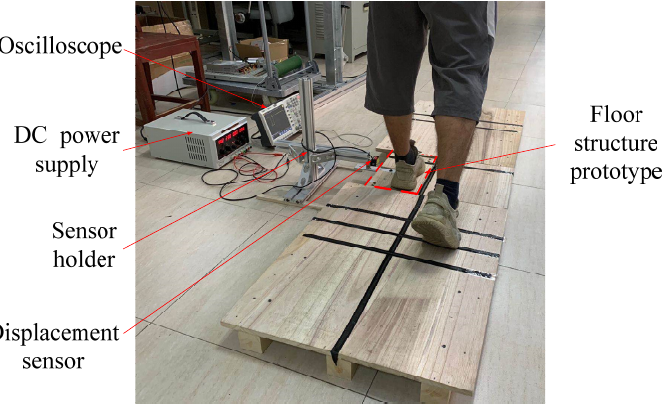
Figure 7. Experimental setup to acquire the displacement data from human footsteps.